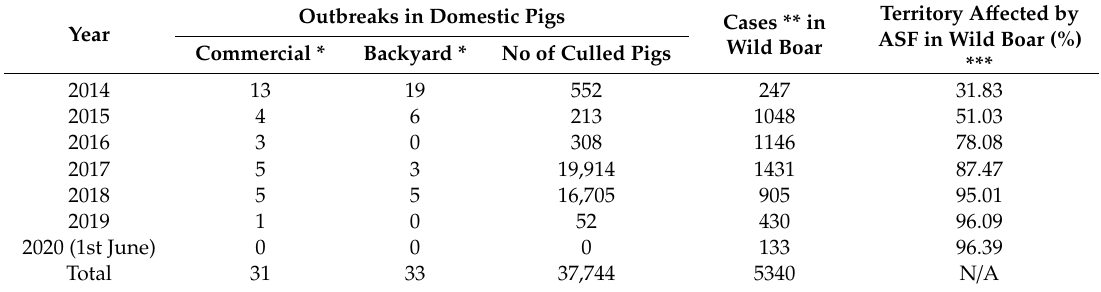
Table 1. African swine fever (ASF) outbreaks and cases in Latvia during